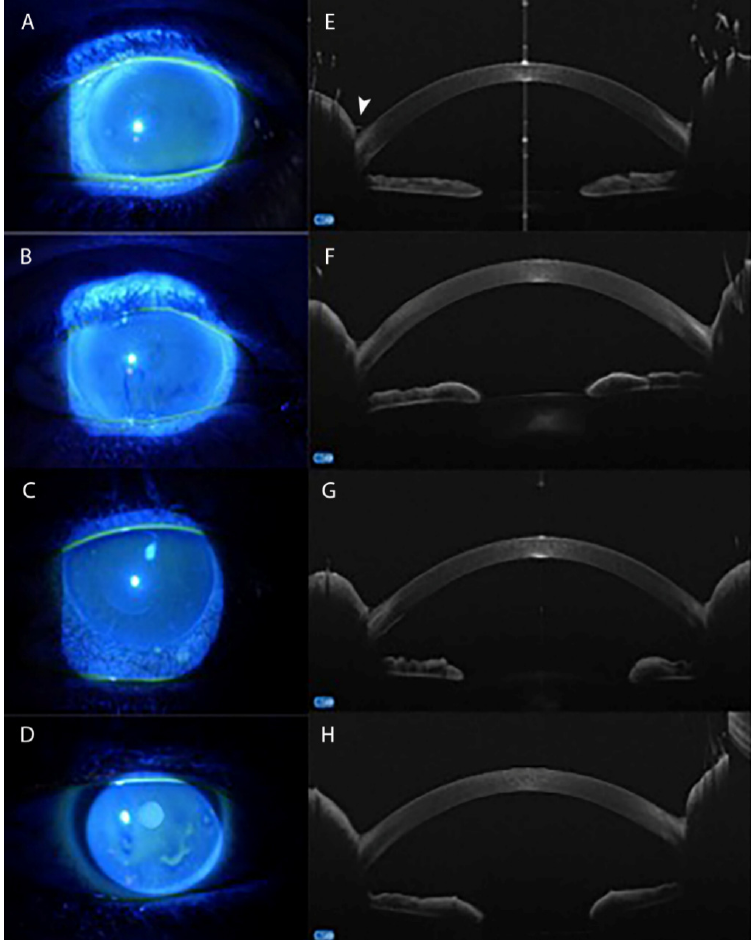
Figure 2. Anterior segment-optical coherence tomography (AS-OCT) of tear meniscus in medically controlled glaucoma. Fluorescein appearance of the tear meniscus and tear film in patients controlled with a preservative-free or preserved PGA mono-therapy ( A , B ), or with two or more drugs per day ( C , D ). AS-OCT shows the progressive reduction of the tear meniscus height (arrowhead) with increasing the number of medications, and the cumulative daily dose of preservative, required to control the disease ( E – H ).